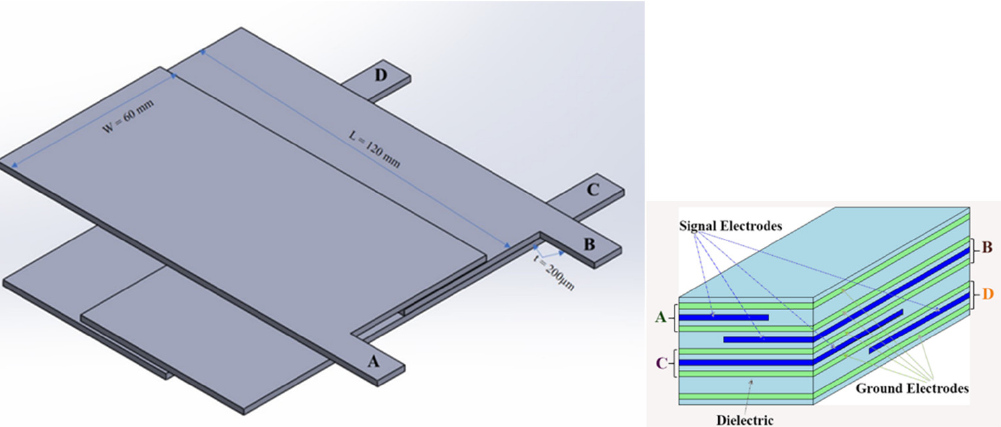
Figure 2. MLC sensor overview: MLC sensor layout with sensors of different sizes overlapping. A unique overlapping arrangement of 4 capacitive sensor arrangement to achieve 15 tactels.